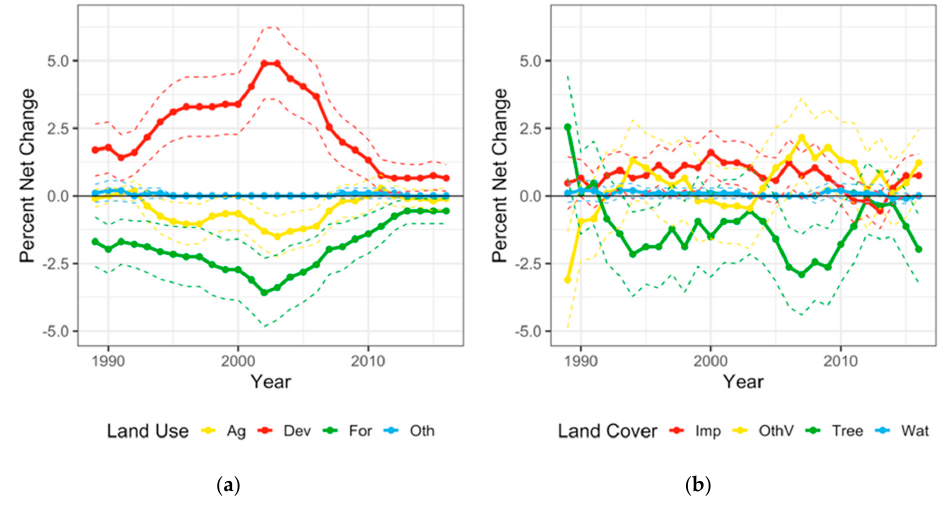
Figure 8. Over five-year intervals, ( a ) net land use change for forest (green), agriculture (yellow), developed (red), and other (blue) land use and ( b ) net land cover change for in tree (green), other vegetation (yellow), barren and impervious (red), and water (blue) with 95% confidence intervals from TimeSync observations. Note that for a five-year interval, the value in year t reflects the difference in land use/cover proportion at time t minus that at time t -5.